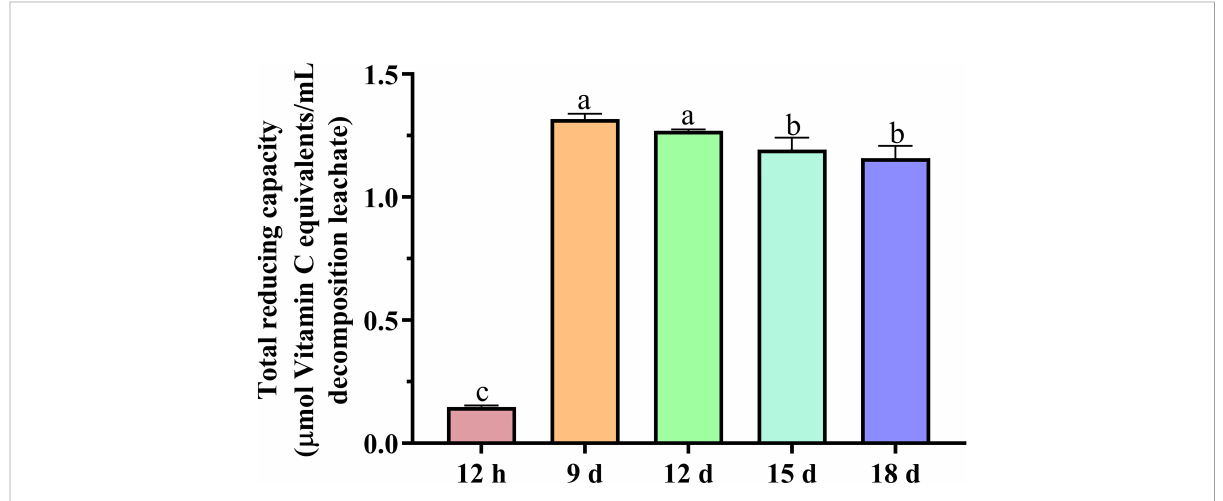
FIGURE 4 Total reducing capacity of the decomposition leachates at different decay times. Different letters denoted signi fi cantly different ( P < 0.05) among different decomposition leachates of decay durations. Bars represent three repetitions ±